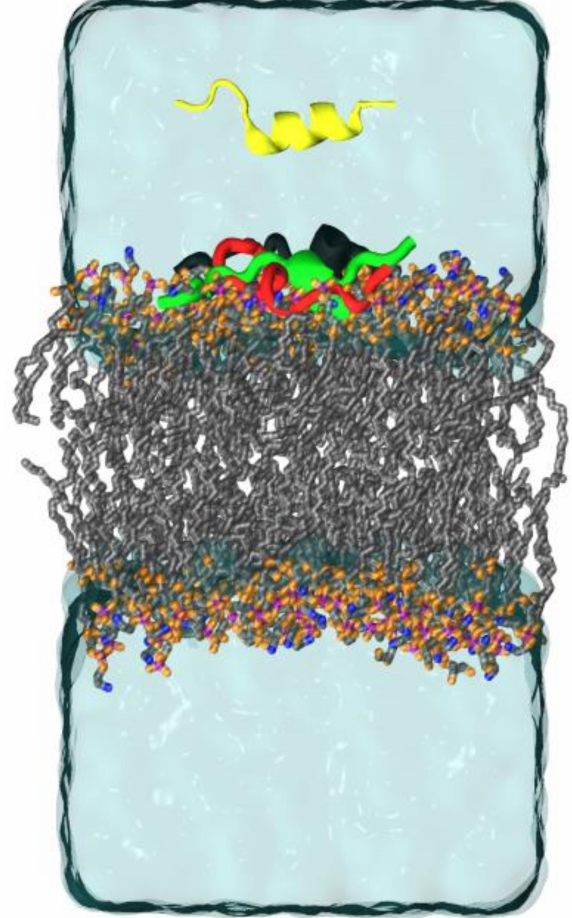
Figure 2. Schematic view of system submitted to MD simulations of Gram-negative bacteria mimicked. XZ plane representation of system with peptide (yellow) above lipid bilayer representing initial condition for all peptides simulated and Stigmurin (black), StigA25 (red) and StigA31 (green) presenting their respective final condition. The lipid molecules are represented as lines, with carbon atoms in gray, nitrogen in blue, oxygen in orange, and phosphorus in